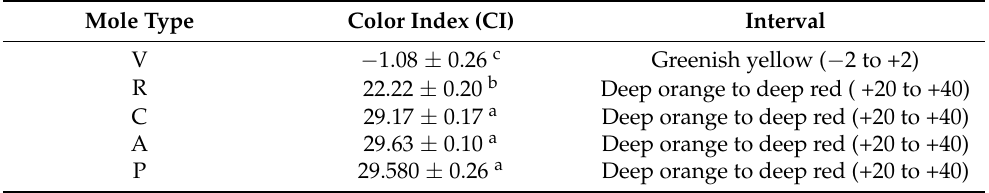
Table 3. The color index of five varieties of mole from the State of